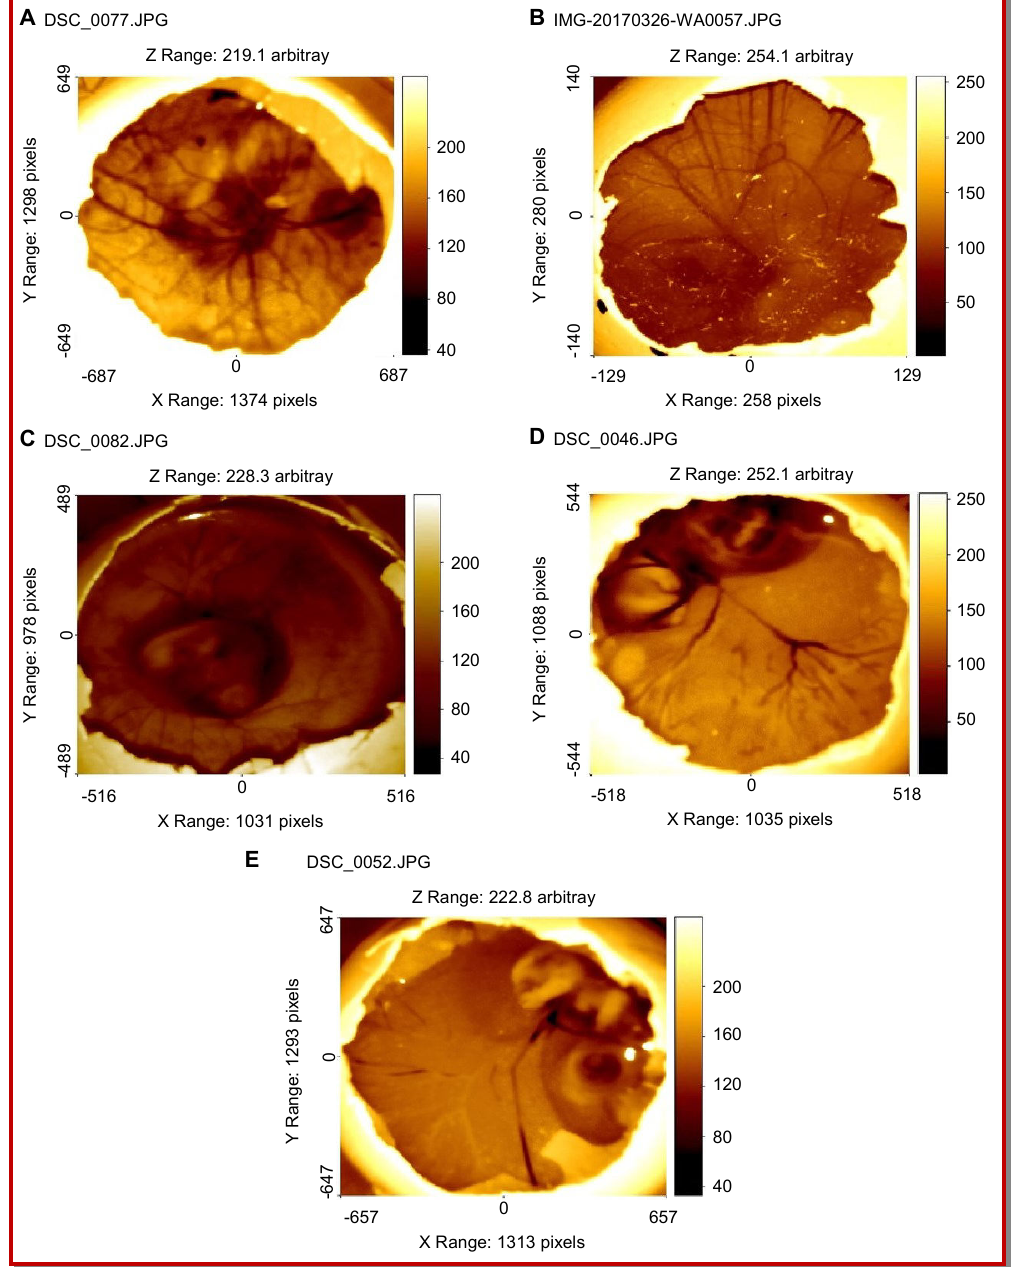
Figure 1: Macroscopic assessment of CAM. Clearly visible CAM vessels i.e. PBVs, SBVs, TBVs and clearly develop CAM region in (A) control normal vessels development. Decreased in CAM region revealed anti-angiogenic actions in treated dilutions of ginger extract i.e. (B) 20 µL, (C) 50 µL, (D) 75 µL, (E) 150